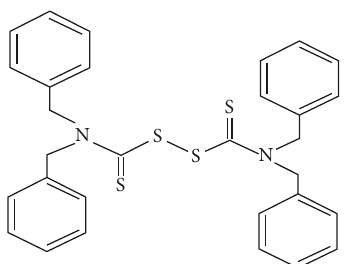
Scheme 1: Molecular structure of tetrabenzylthiuram disulphide